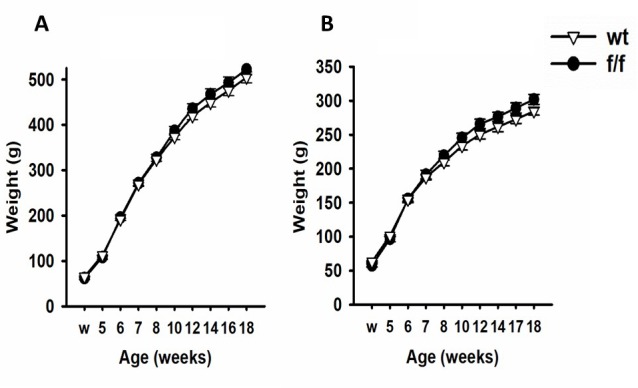
SD:nr3c1fl/fl (f/f) rats did not differ in bodyweight compared to SD:nr3c1wt (wt) controls.Male (A) and female (B) fl/fl and wt rats did not differ in weight at weening (w) or over the course of the experiment.